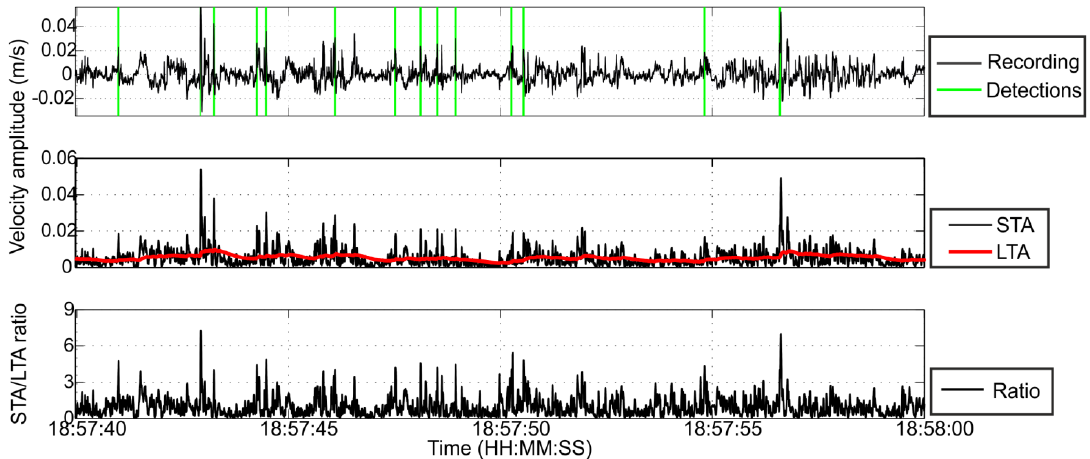
Figure 5. Example of waveform analyzed with STA/LTA. Upper part: filtered recordings for 20 s of data. The green vertical lines are the detections of the STA/LTA. Middle part: STA (black) and LTA (red) functions for the corresponding data period. Lower part: STA/LTA